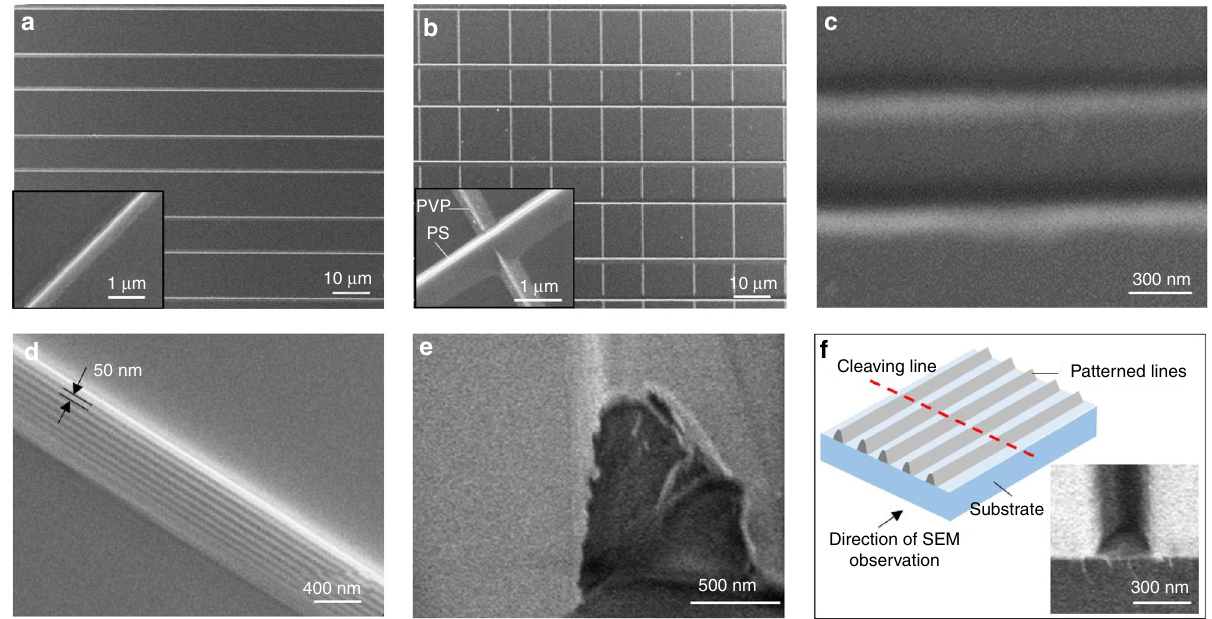
Fig. 2 Scanning electron microscopy images of patterned structures. a Line pattern of 2008P, a polymeric semiconductor. b Grid structure composed of sequentially patterned PVP and polystyrene lines. c Fabricated PS lines with about 300 nm resolution and 150 nm feature. d Self-assembled secondary pattern (resolution around 50 nm) on a primary PS line. e , f SEM images of cross sections of patterned PS lines with different feature sizes and schematic drawing to illustrate of how the sample was cleaved and